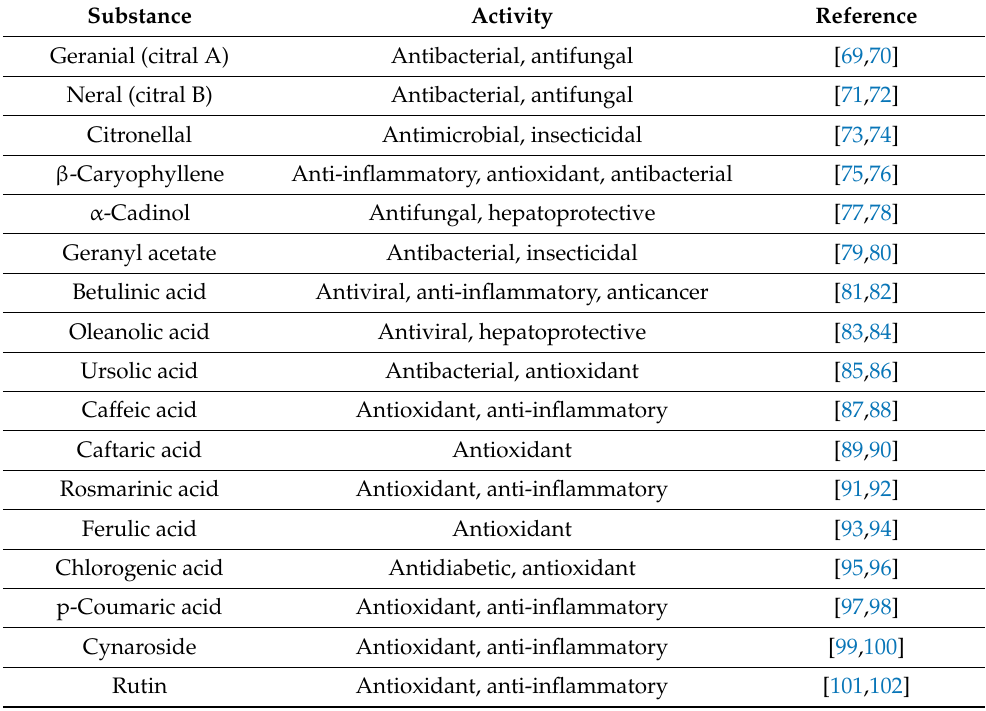
Table 5. Main components of Melissa officinalis and their